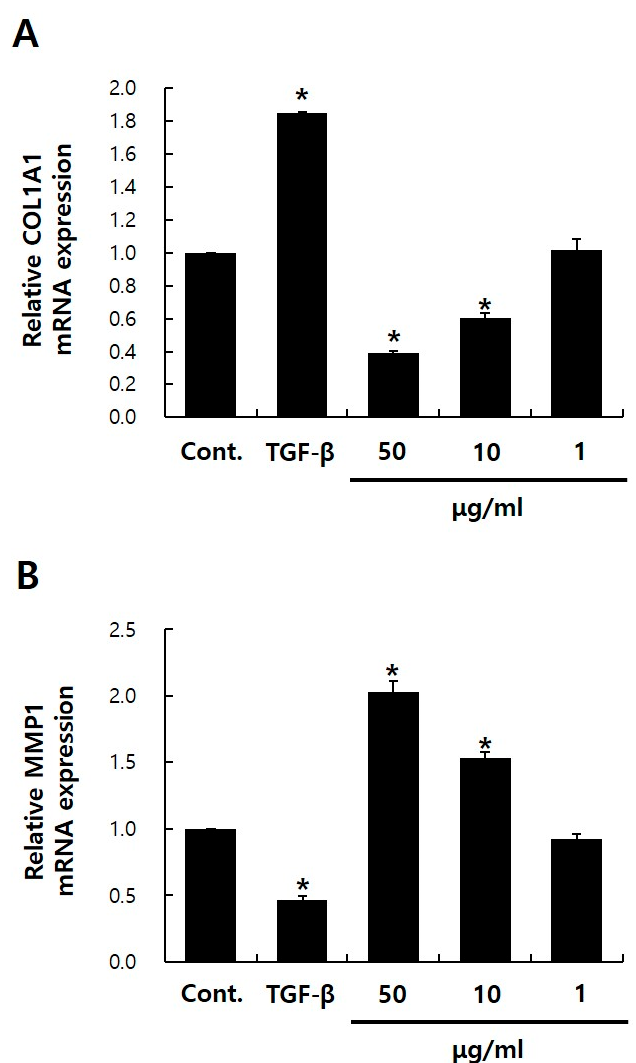
Figure 2. Characterization of PGE2 treatment in NHDFs. Real-time quantitative reverse transcription polymerase chain reaction (qRT-PCR) analysis of dermal fibroblast markers collagen, type I, alpha 1 (COL1A1) ( A ) and matrix metallopeptidase 1 (MMP1) ( B ). transforming growth factor beta (TGF- β ) was used as a positive control. Values represent the mean ± SD of three independent experiments. * p < 0.05 compared to the control. Control means NHDFs treated with DMSO.